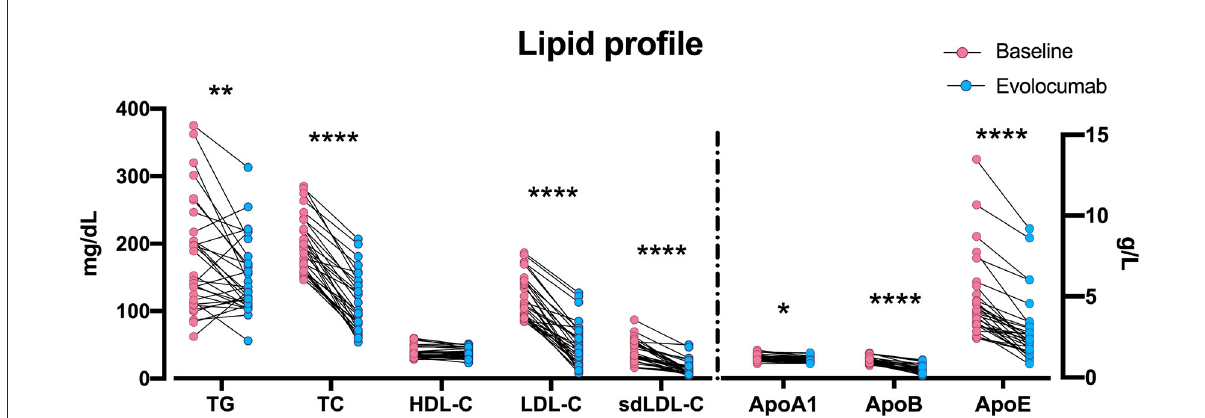
FIGURE3 Changes in lipid particles at 72h post-evolocumab administration. Scattered plot of lipid profile data in Table 2. The dots of TG, TC, HDL-C, LDL-C, and sdLDL-C are aligned to the left Y axis, and the dots of Apo-A1, Apo-B, and Apo-E are aligned to the right Y axis. * P < 0.05, ** P < 0.01, **** P < 0.0001. Differences were tested using Wilcoxon matched-pairs signed rank test. TG, triglyceride; TC, total cholesterol; HDL-C, high-density lipoprotein cholesterol; LDL-C, low-density lipoprotein cholesterol; sdLDL-C, small dense low-density lipoprotein cholesterol; Apo,